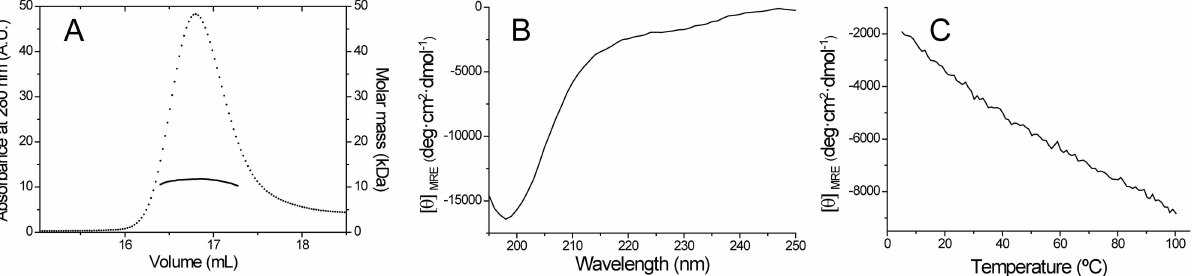
Fig 2. KISS1 is monomeric and has little secondary and no tertiary structure in solution. (A) Size exclusionchromatogram of KISS1 (thin line and axis to the left), and molar mass derivedfrom MALS (thick line and axis to the right). (B) CD spectrum of KISS1 at 25˚C. (C) Thermal denaturation as measuredby changesin the mean residue molar ellipticity at 222